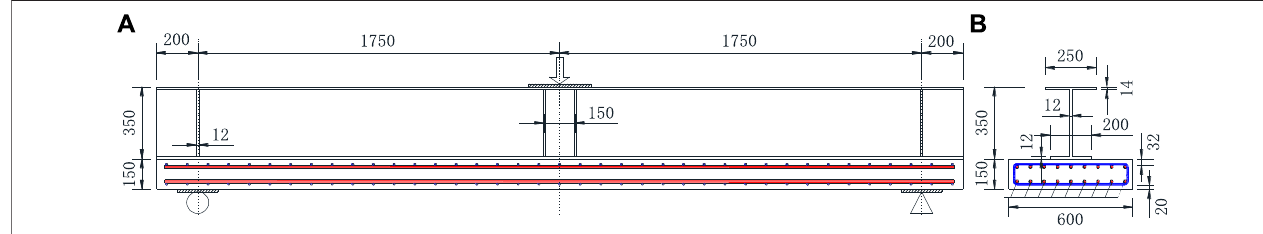
FIGURE 6 | Dimension details of the test specimen (unit: mm): (A) front elevation and (B) side elevation.